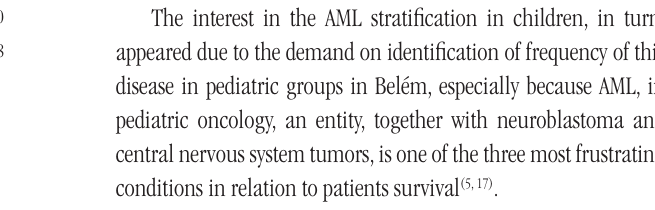
taBLE 2 – AML subtypes in children aged 0 to 17 years Subtype